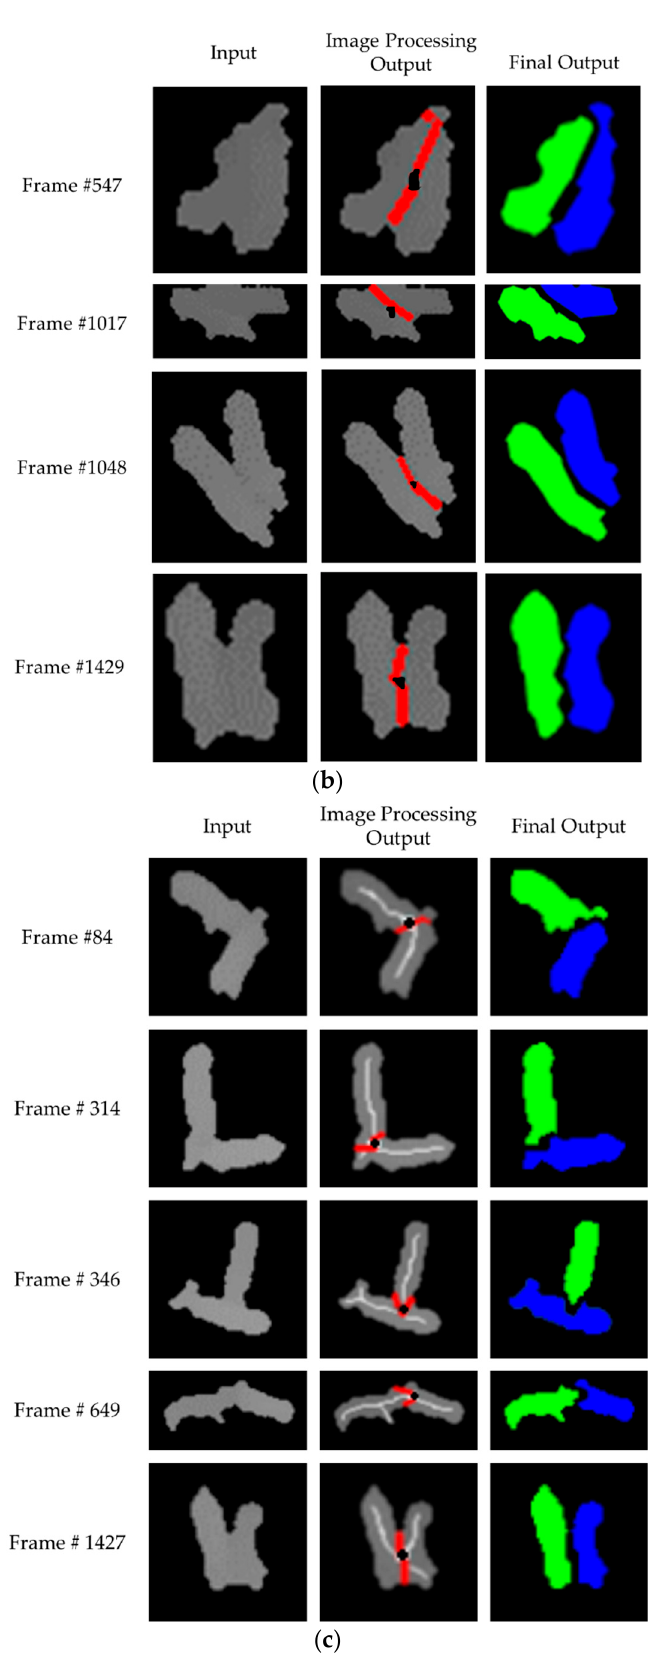
Figure 17. Separation results with the Image Processing Module: ( a ) separation with natural holes; ( b ) separation with artificial holes using the erosion operator; ( c ) separation with artificial holes using the skeleton operator.